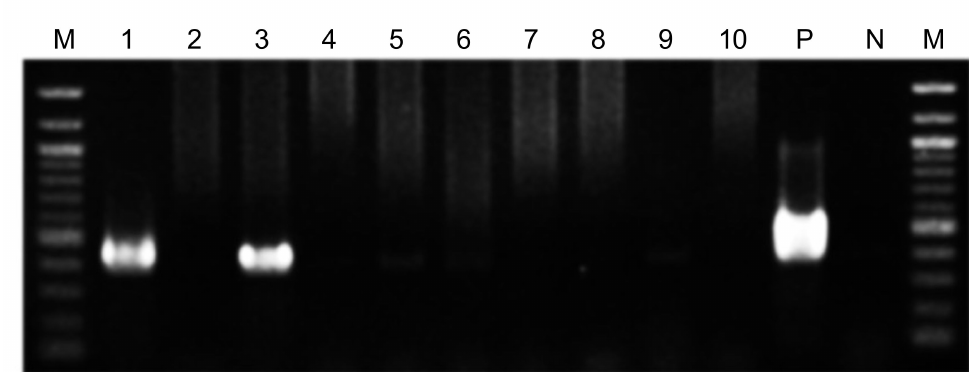
Figure 6. Detection of Helicobacter pylori in oral samples. Polymerase chain reaction results showing the second-step PCR assay using ureA -bF and ureA -aR primer sets for detection of H. pylori in oral samples. Lanes: 1, extracted tooth; 2, saliva taken immediately pre-operation; 3, suture taken 10 days post-operation; 4, saliva taken 10 days post-operation; 5, splint taken 10 days post-operation; 6, dental plaque (upper left second premolar) taken 30 days post-operation; 7, dental plaque (lower left second premolar) taken 30 days post-operation; 8, dental plaque (lower right second premolar) taken 30 days post-operation; 9, dental plaque (lower right second molar) taken 30 days post-operation; 10, saliva taken 30 days post-operation; P (positive control), H. pylori ATCC 43504; N (negative control), sterile water; M, 100-bp DNA ladder.